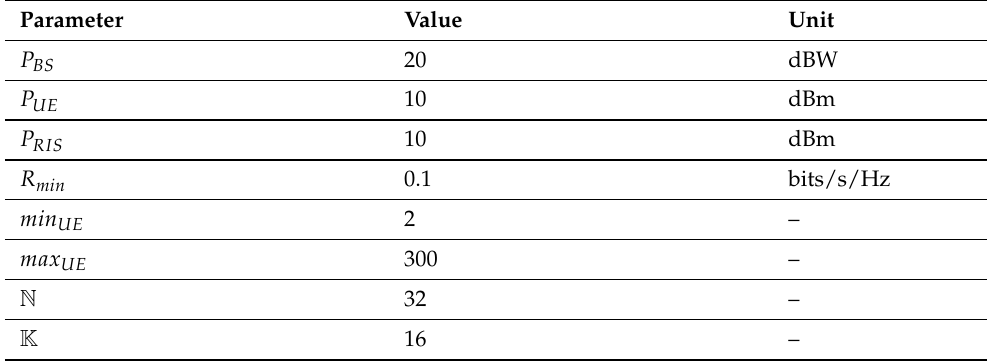
Table 2. Simulation